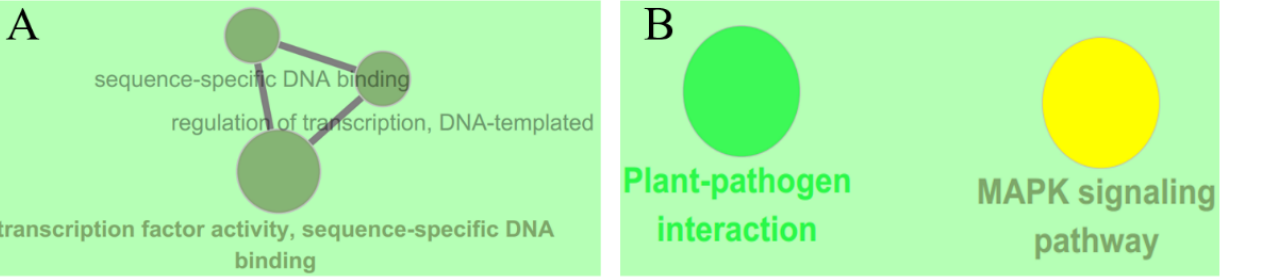
Figure 2. The function analysis of differentially expressed WRKYs in wild tomato S. habrochaites LA1777 under On -lz infection. ( A ) The result of GO enrichment on molecular function term, and ( B ) The result of KEGG enrichment. The GO and KEGG enrichment were both analyzed in Cytoscope using ClueGO app.